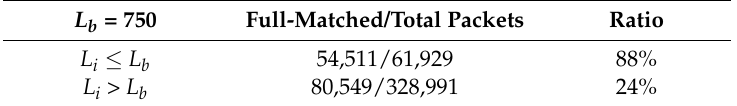
Table 4. The ratio of number of full-matched packets and total number of packets in input